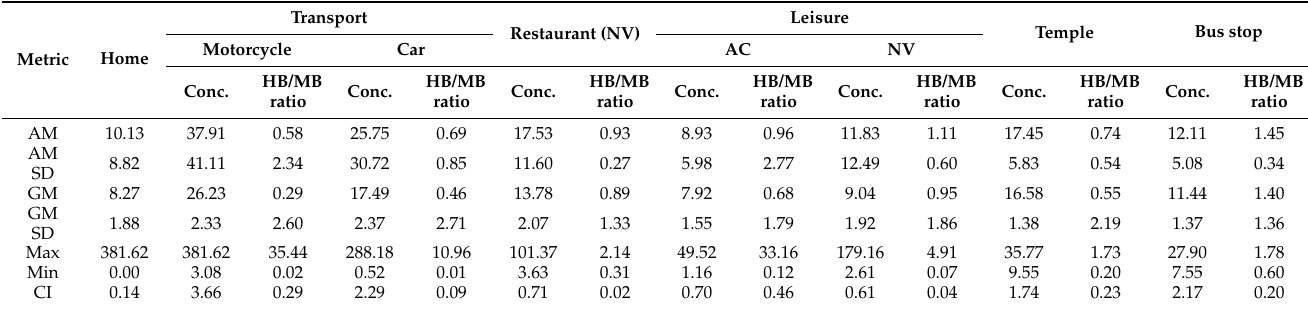
Table 1. BC personal exposure concentrations and ratio of mean BC concentrations from home-based (HB) and mobility- based (MB) participants (simultaneous measurement, the ratios are calculated pairwise) in different MEs in Trivandrum.